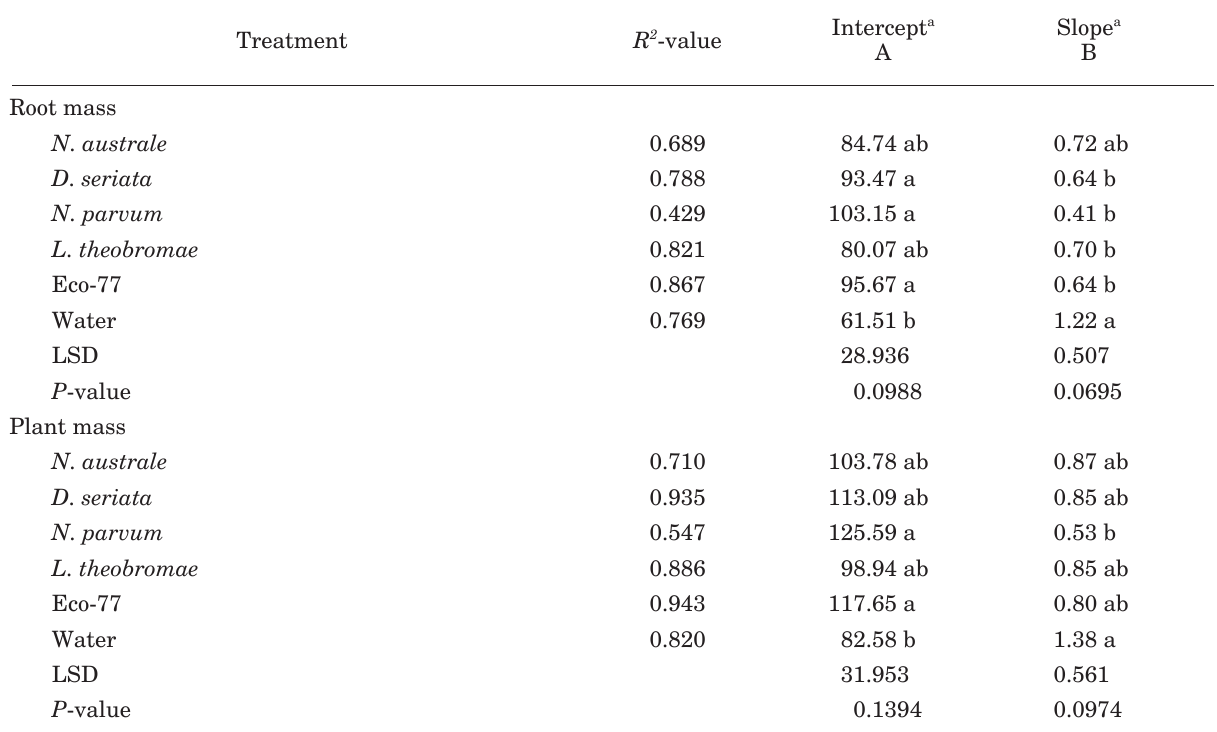
Table 1. Mean intercept (A), slope (B) and R 2 -values of equations ( y =a x + b) following linear regression analysis of the means of root, shoot or plant mass over the irrigation regime of potted grapevines subjected to control treatment or inoculated with Neofusicoccum australe , N. parvum , Lasiodiplodia theobromae or Diplodia seriata